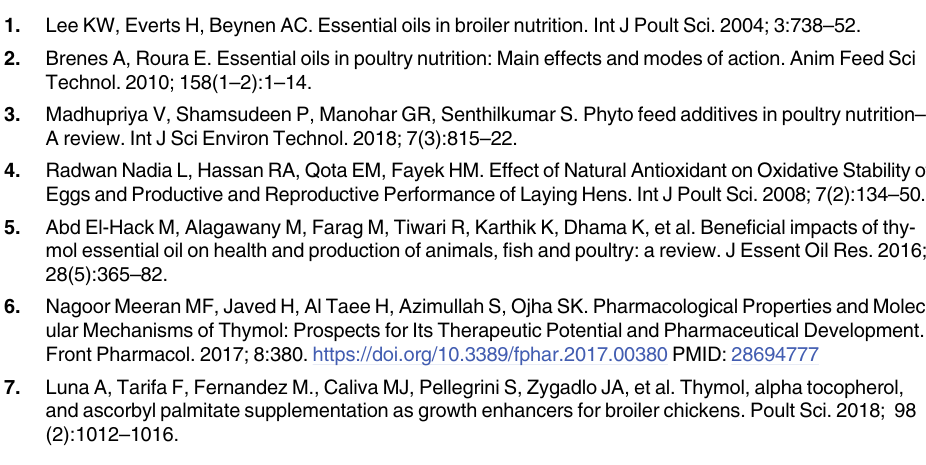
S4 Table. Thymol concentration in supplemented feed and percentage incorporated into feed. S5 Table. Percentage of thymol transferred to egg yolk and droppings in relation to the amount